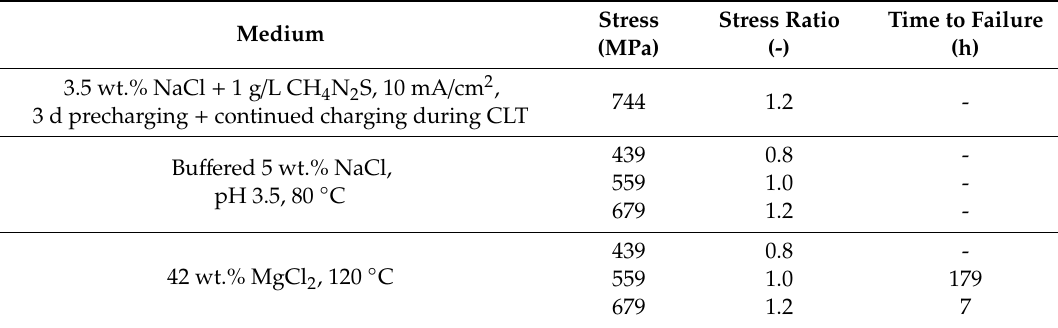
edge of the sample, ( c ) inter- and transgranular cracking in the centre of the sample.